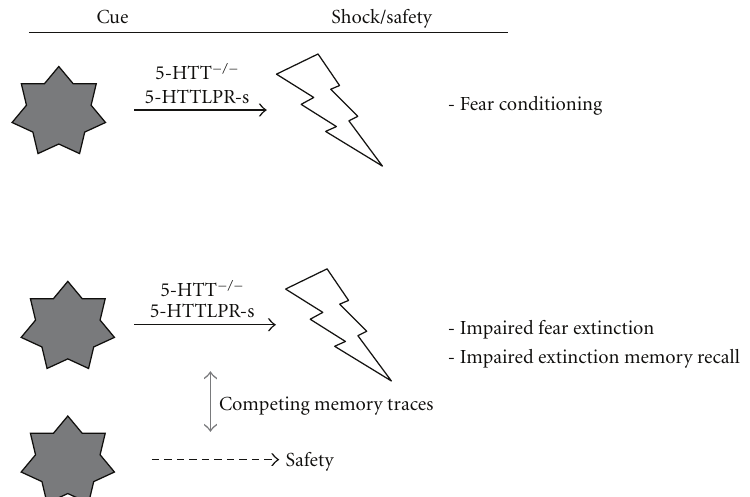
F 4: Potential explanation for the differential effects of genetic 5-HTT downregulation in humans and rodents on fear conditioning, expression, extinction, and extinction recall. 5-HT may strengthen associative learning processes, and thereby the association between a CS and shock (CS-shock memory trace). During extinction subjects acquire a second memory, namely, between the CS and safety (CS- safety memory trace). It depends on the competition between the two, what the behavioural expression of subjects will be. Because 5- knockout rodents and 5-HTTLPR s-allele carriers are sensitive to motivationally relevant stimuli, the CS-shock memory trace may be HTT �stronger� than the CS-safety memory trace, and thus prevail. e speci�c environmental conditions (e.g., housing, novelty) may determine −/− at which phase (conditioning, expression, extinction, extinction recall) this CS-shock memory is